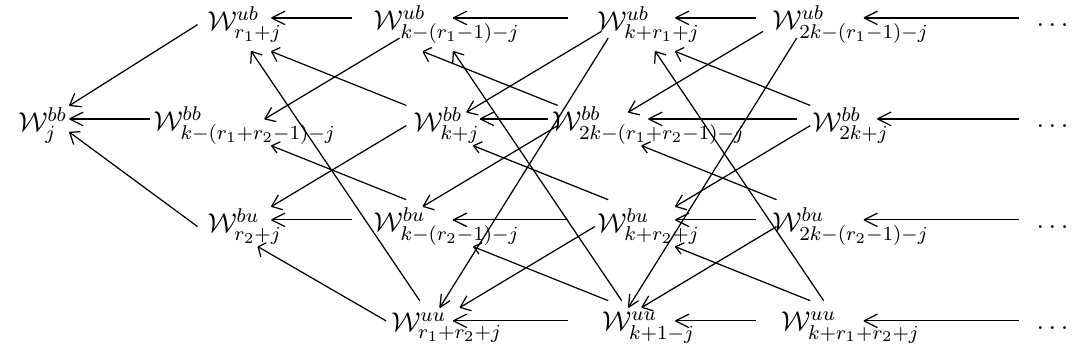
Figure 23 . The corrected 2BTL inclusion diagram, replacing the one published in [49]. The repeated part of the diagram is such that all standard modules beyond those in the (cid:12)rst three columns each have three out-going